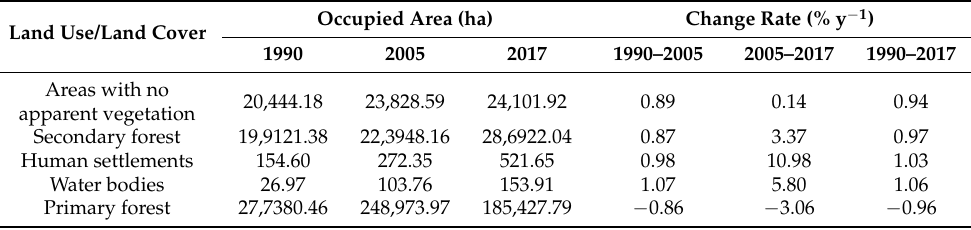
Table 4. Covered area and change rates of land use/land cover for the years 1990, 2005 and 2017.